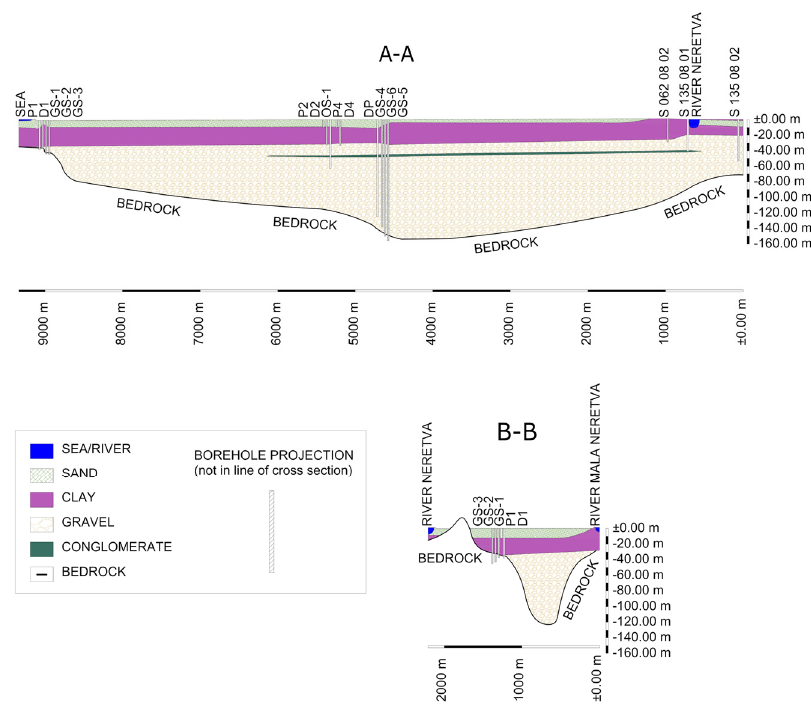
Figure 2. Geological cross-sections 1-1 and 2-2 of the River Neretva